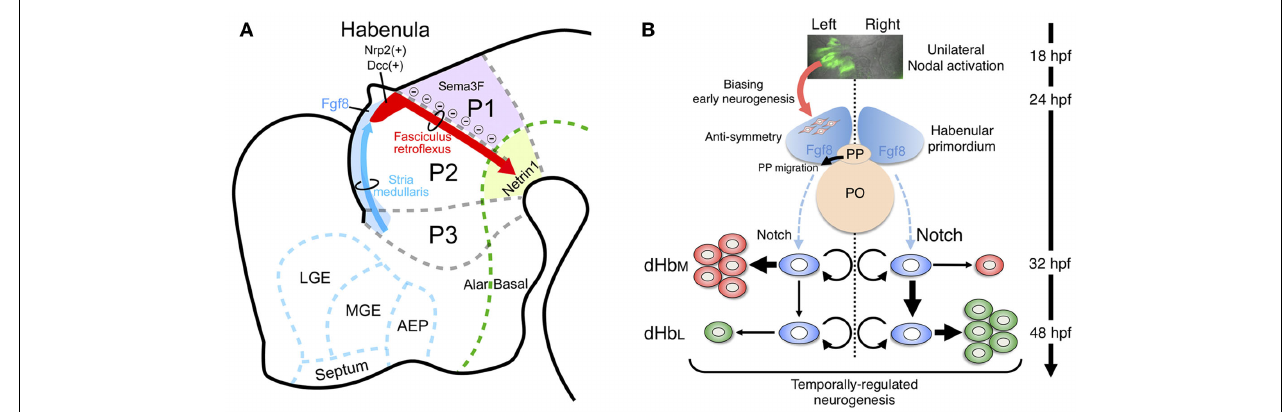
18–24h postfertilization (hpf), Nodal, and its downstream genes (green in the top panel showing dorsal view ofTg[ lefty1 : GFP ]) are activated in the left dorsal diencephalon. Unilateral activation of Nodal signaling in the dorsal diencephalon directs the parapineal migration toward left (black arrow in the middle panel) and biases early neurogenesis in the habenular primordium with anti-symmetric nature in the presence of Fgf8 (red arrow between top and middle panels). Under those influences, common neural stem cells (light blue in the bottom panel) in the habenular primordium start to generate neural precursors for the lateral subnucleus (dHbl, red in the bottom panel) predominantly on the left side, under the influence of reduced Notch activity, and then neural precursors for the medial subnucleus (dHbM, green in the bottom panel) predominantly on the right side during late stages of neurogenesis peaked at 48hpf. PO, pineal organ; PP, parapineal organ.